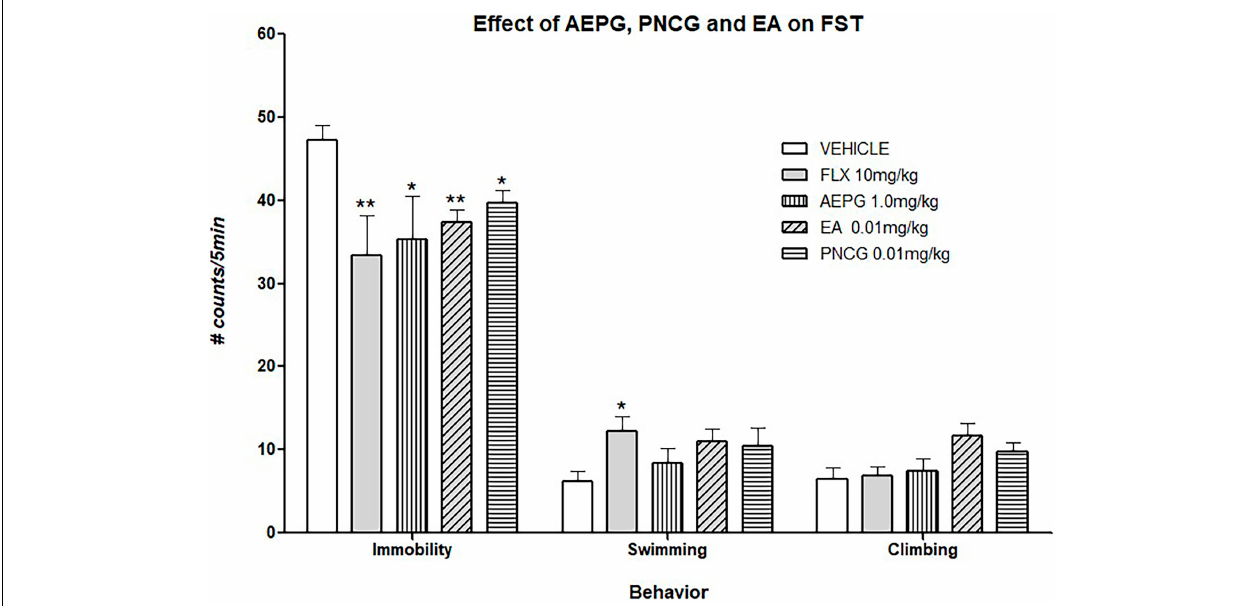
FIGURE 8 | Effect of chronic treatment of AEPG and the fractions that contain EA and PNCG on ovariectomized rats subjected to forced swimming test. FLX antidepressant was used as positive control. Data are presented as the mean (S.E.M.) of the number of counts of immobility, swimming, and climbing behavior in a 5-min test session. Comparisons vs. control group (saline solution). One-way ANOVA test ** p < 0.005, * p < 0.05 versus control group. AEPG = aqueous extract of Punica granatum (1.0 mg/kg), EA = ellagic acid (0.01 mg/kg), PNCG = punicalagin (0.01 mg/kg). FLX = fluoxetine (10